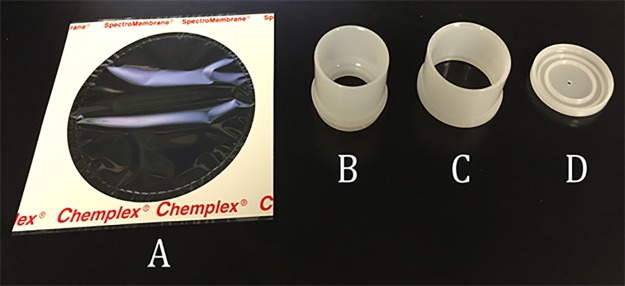
Mylar® and individual cup components that make up the cell culture system.Mylar® (A) provided a surface that allowed cells to grow in the same manner as if grown on standard tissue culture plastic, while also being thin enough to allow x-rays to pass through without significant attenuation. The Mylar® was pressed between the inner (B) and outer (C) cup components with a ventilation cap (D) to allow proper air-flow.